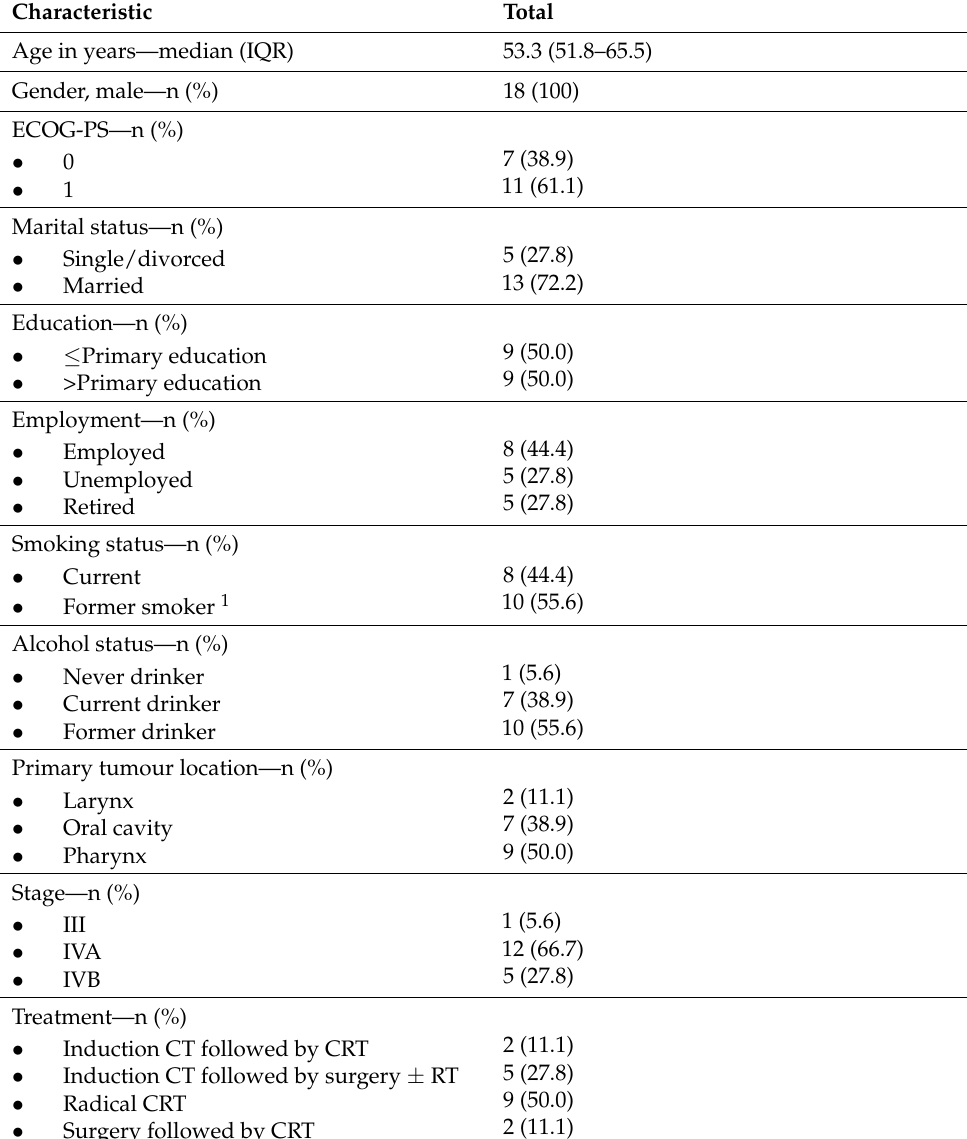
Table 1. Patients’ baseline sociodemographic and disease-related characteristics (n = 18).